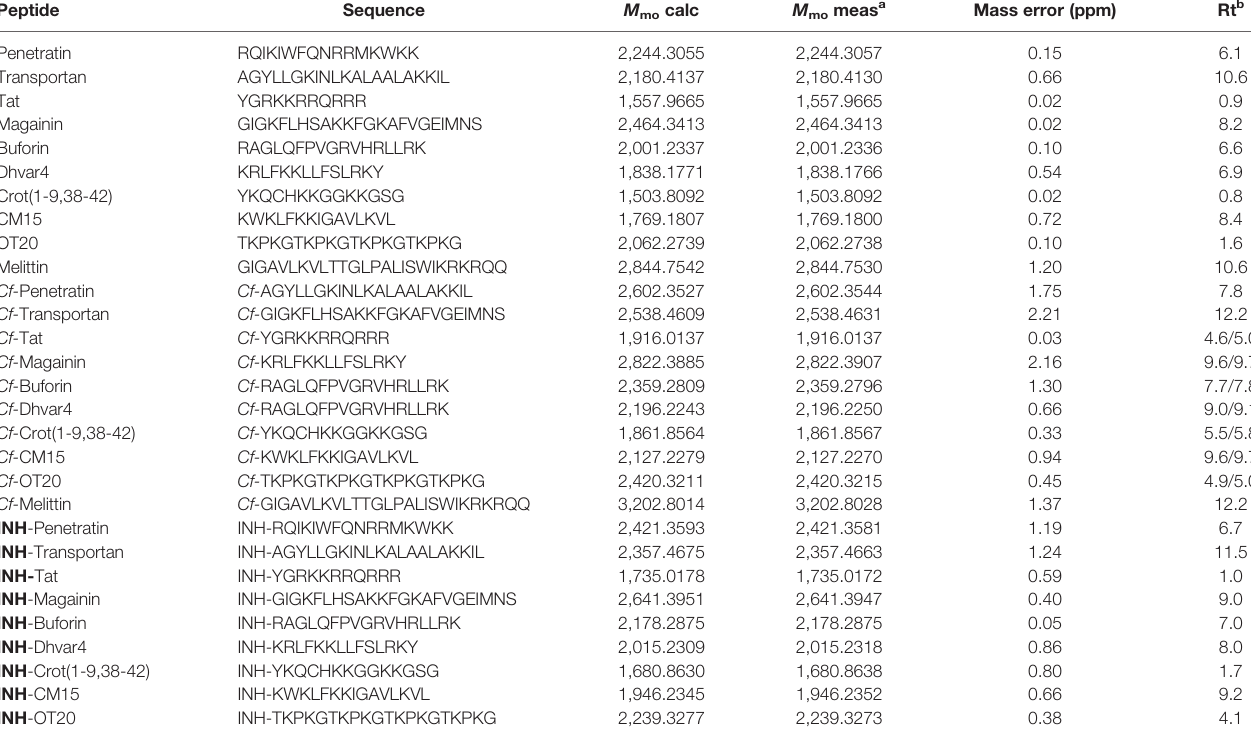
TABLE 1 | Analytical characteristics of the peptides and peptide conjugates. Peptide